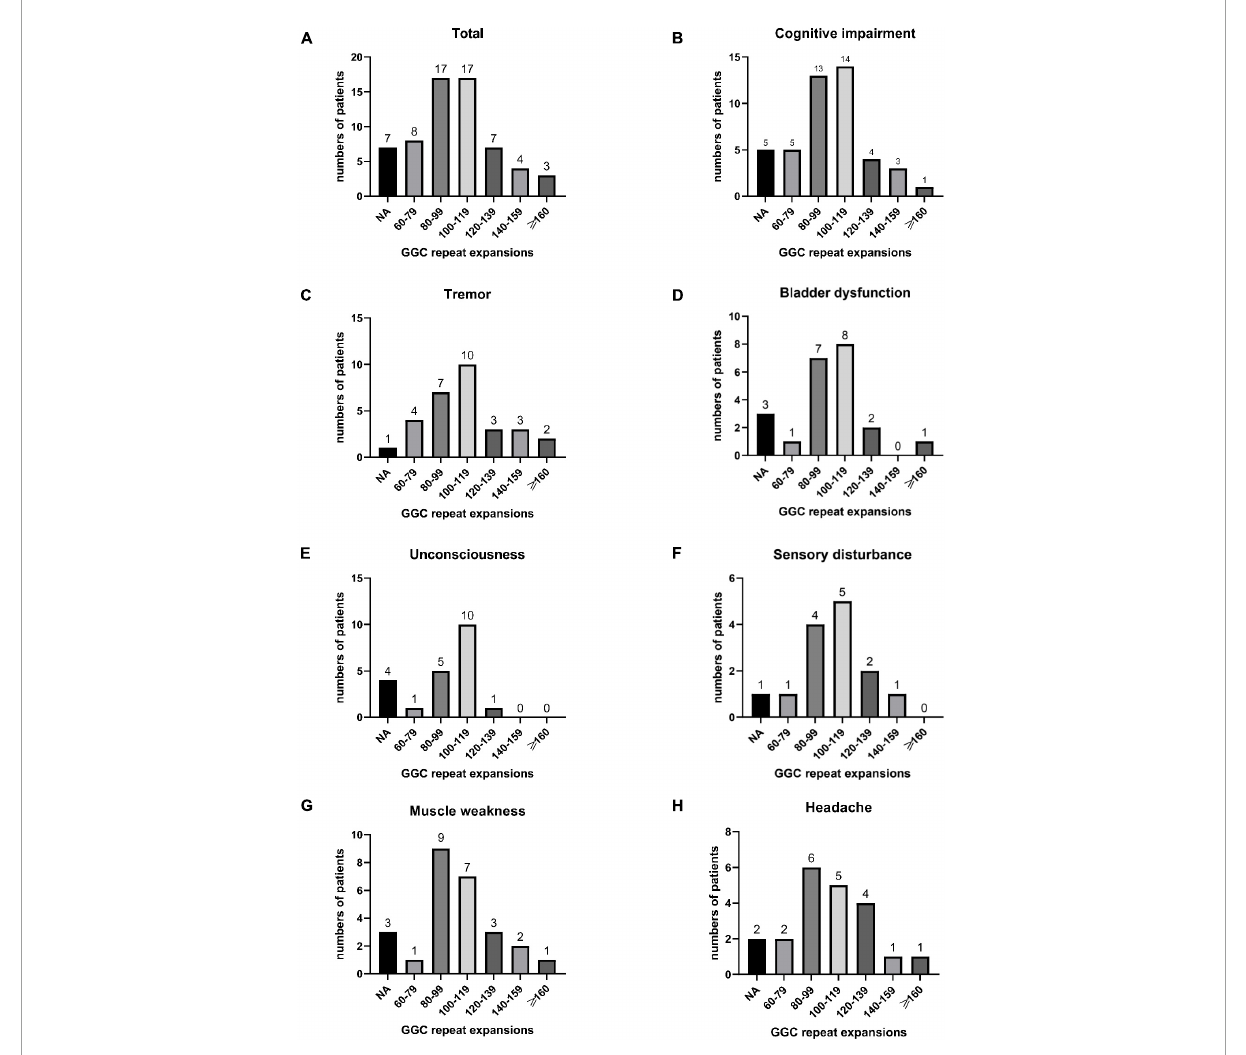
FIGURE5 Number of all NIID patients in different GGC repeat number intervals (A) ; The number of patients with cognitive impairment (B) , tremor (C) , bladder dysfunction (D) , unconsciousness (E) , sensory disturbance (F) , muscle weakness (G) , and headache (H) distributed in different GGC repeat number